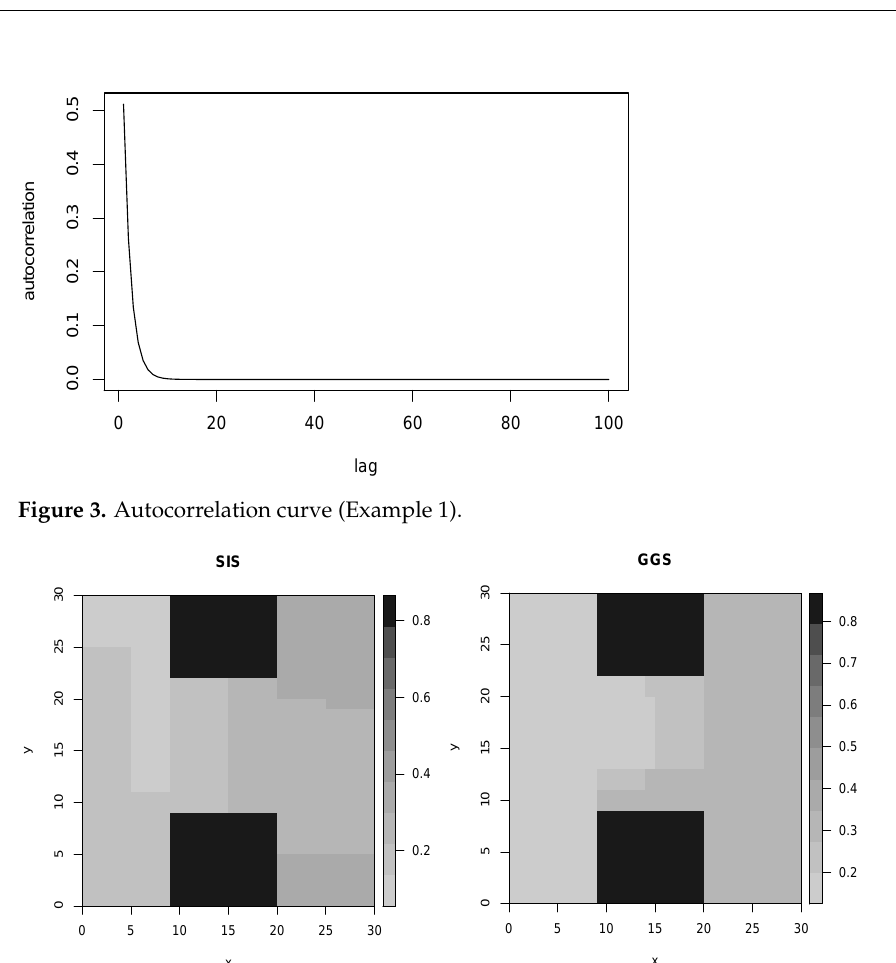
Figure 4. Surface profiles as determined by the generalized Gibbs sampler (GGS) and the Sequential Importance Sampling (SIS) algorithms in Example 1.